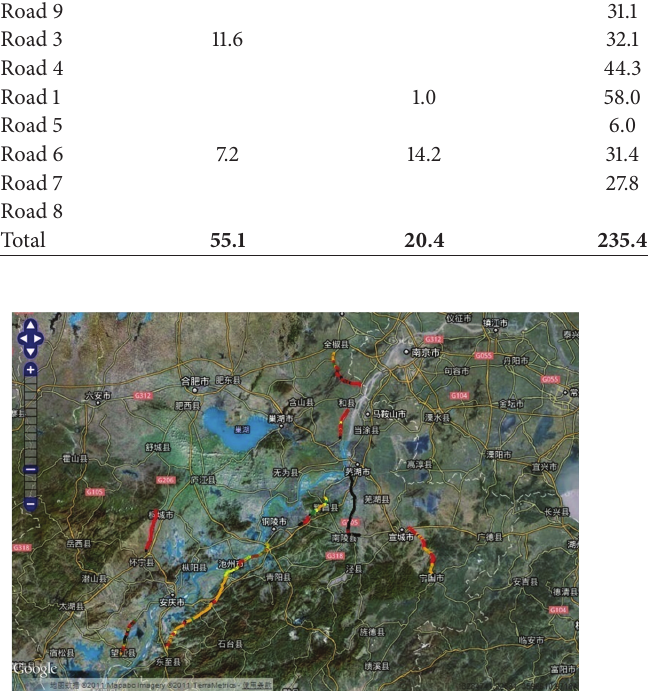
Figure 1: RIOH all occupants of accident density map.